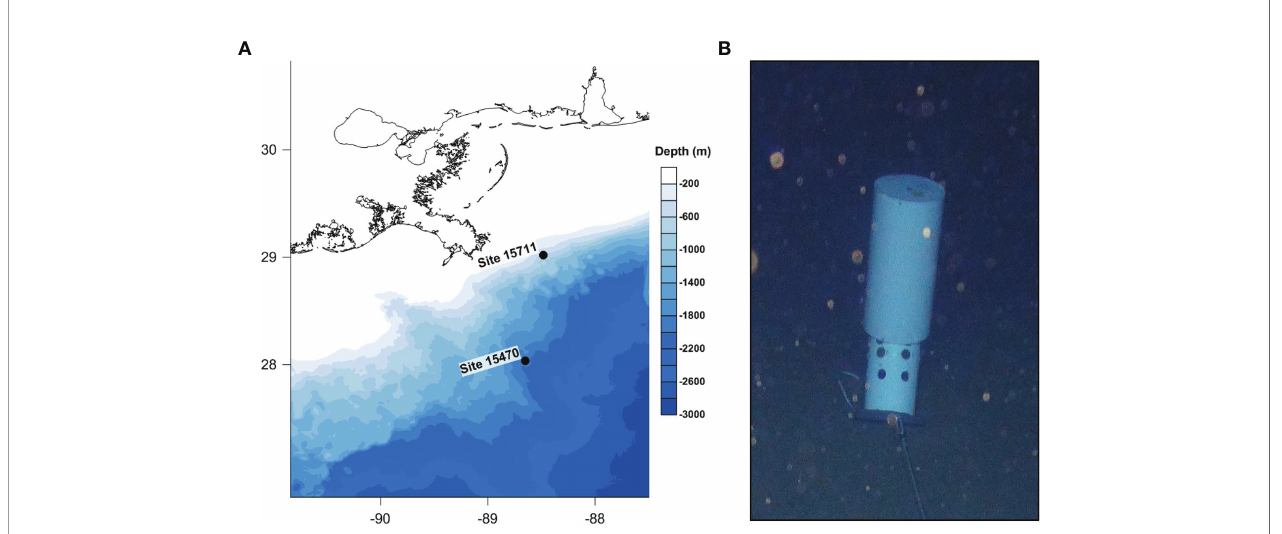
FIGURE 1 | (A) Map depicting the location of historic wooden shipwreck sites in the northern Gulf of Mexico. (B) Image of submerged MRE on the sea fl oor with the cover fl oating and coupons